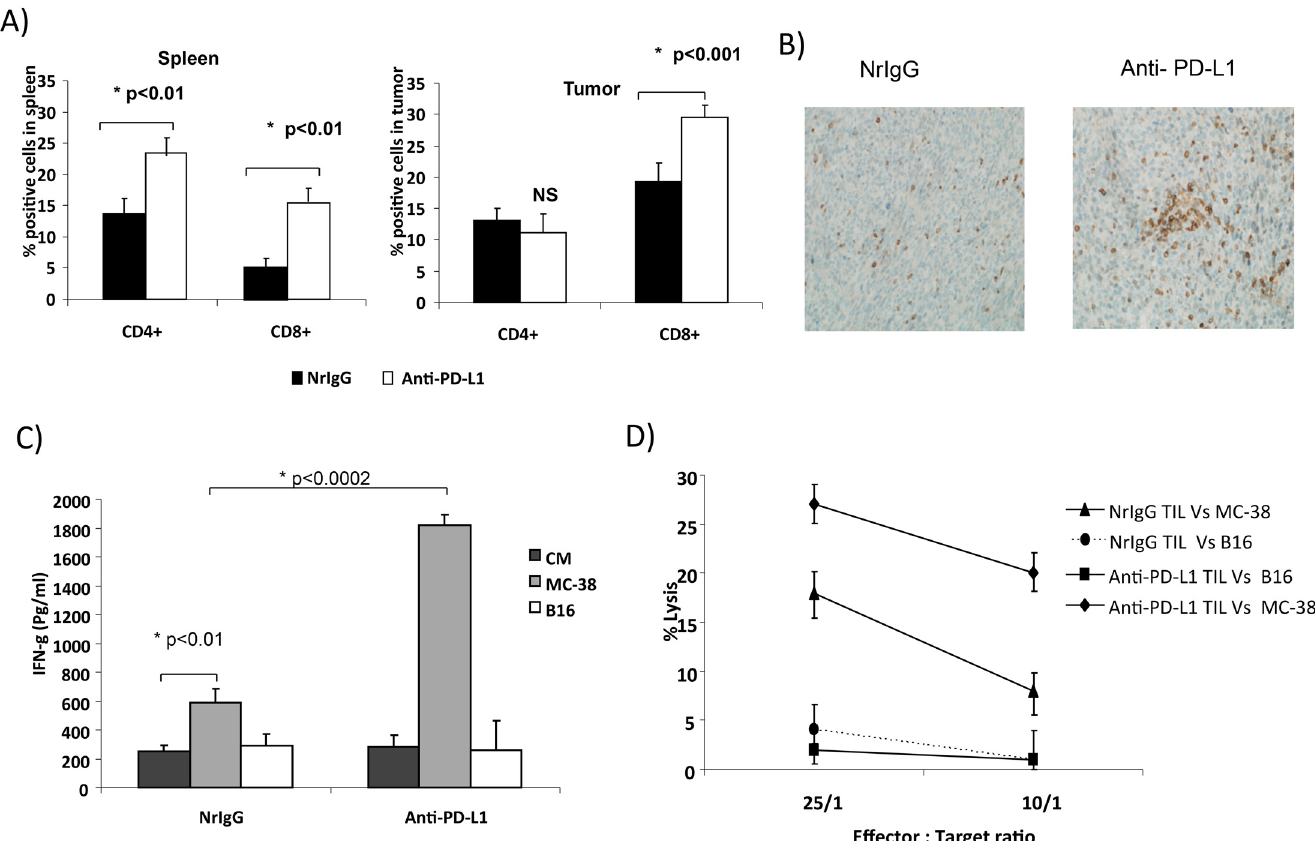
Fig 4. PD-L1 blockade increases T cell infiltration and enhances cytotoxic function of TIL. A) Bar graph represents CD4 and CD8+ T cell infiltration in spleen and tumors (n = 8); B) CD3+ T cell infiltration in tumor (n = 8); C) measurement of IFN- γ by ELISA; D) Percent of 51 Cr release by TIL.